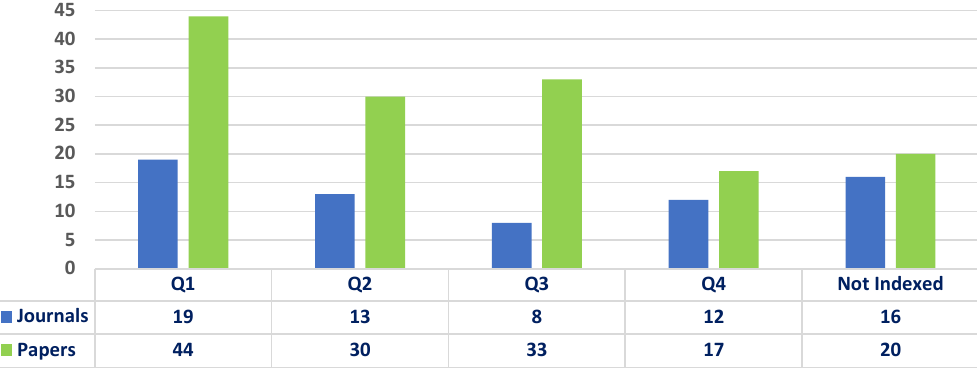
Figure 8. Quartile distribution of the number of journals and papers according to Journal Citation Reports (year